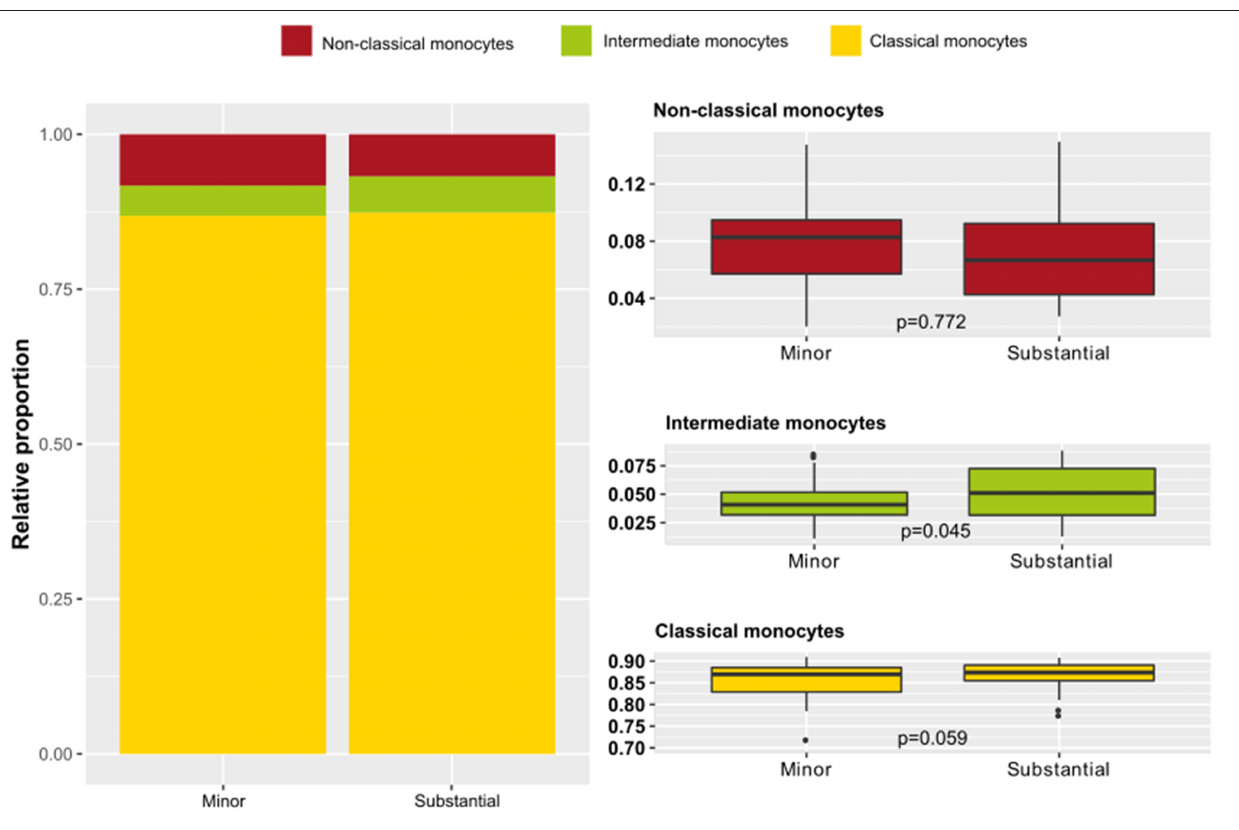
FIGURE 2 | Monocyte subset proportions according to extent of myocardial injury in acute coronary syndrome (ACS) patients. Presented are data from the ACS cohort ( n = 82) including patients with substantial ( n = 42) and with minor myocardial injury ( n = 40). ACS patients were stratified as having minor or substantial myocardial injury defined by high sensitivity cardiac troponin I values (99th percentile cut-off). Left: proportions of monocyte subsets in ACS patients with minor vs. substantial myocardial injury. Right: distribution of the specific monocyte subsets in relation to the extent of myocardial injury.